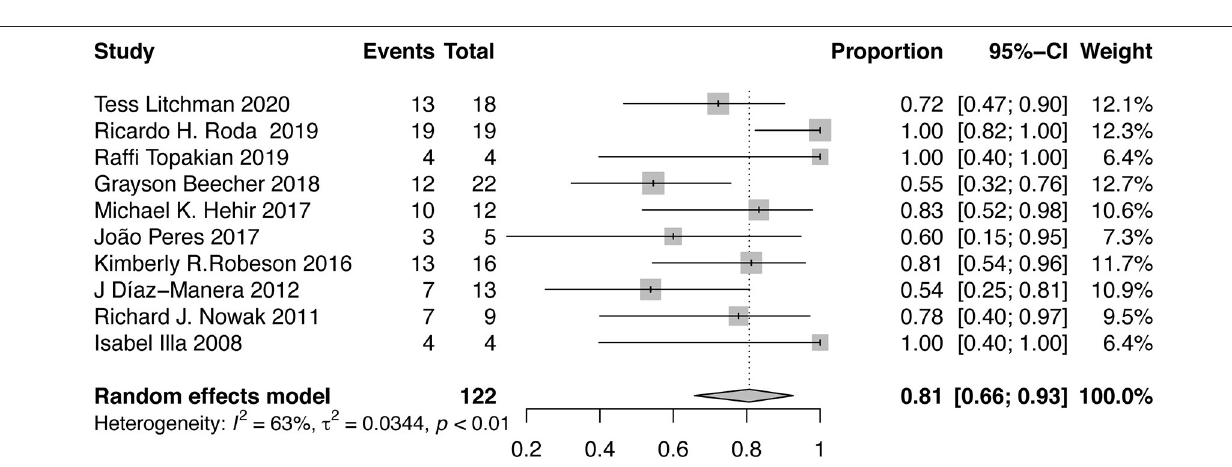
FIGURE 5 | Forest plot showing the mean effect size and 95% CI for the proportion of patients discontinuing oral immunosuppressants.